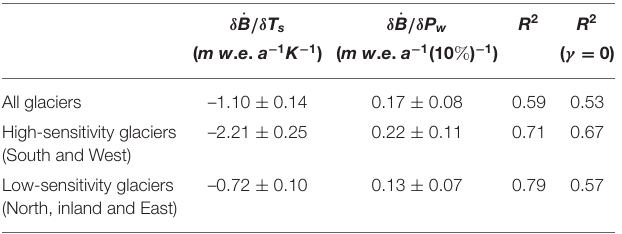
TABLE 2 | Mass-balance sensitivities of the glaciers to a 1 ◦ C rise in temperature and to a 10% increase in precipitation.